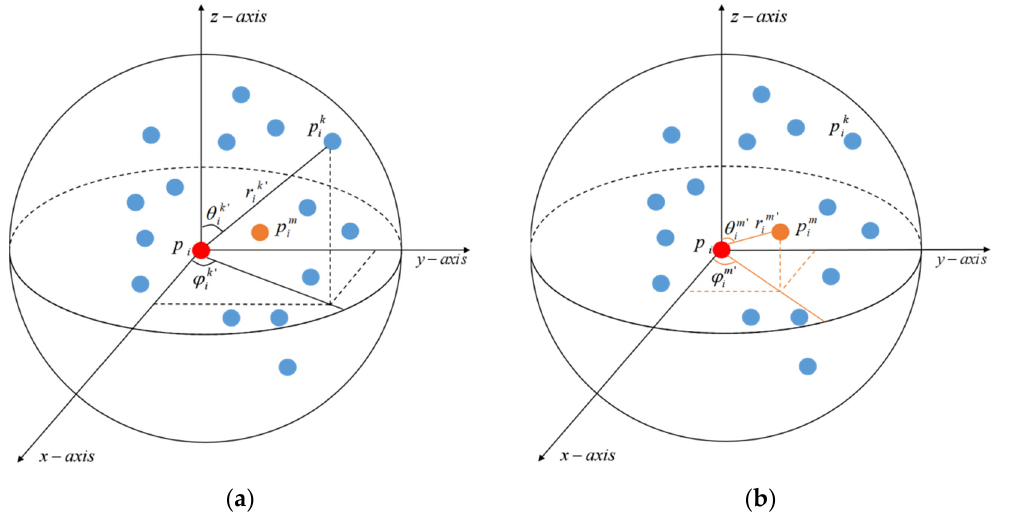
Figure 4. The conversion from the Cartesian coordinate system to the spherical coordinate system. ( a ) The spherical coordinate system spatial information between the centre point and each of its k th neighbouring points. ( b ) The spherical coordinate system spatial information between the centre point and the centre of mass. (Red: centre point; Blue: neighbouring points; Yellow: the centre of